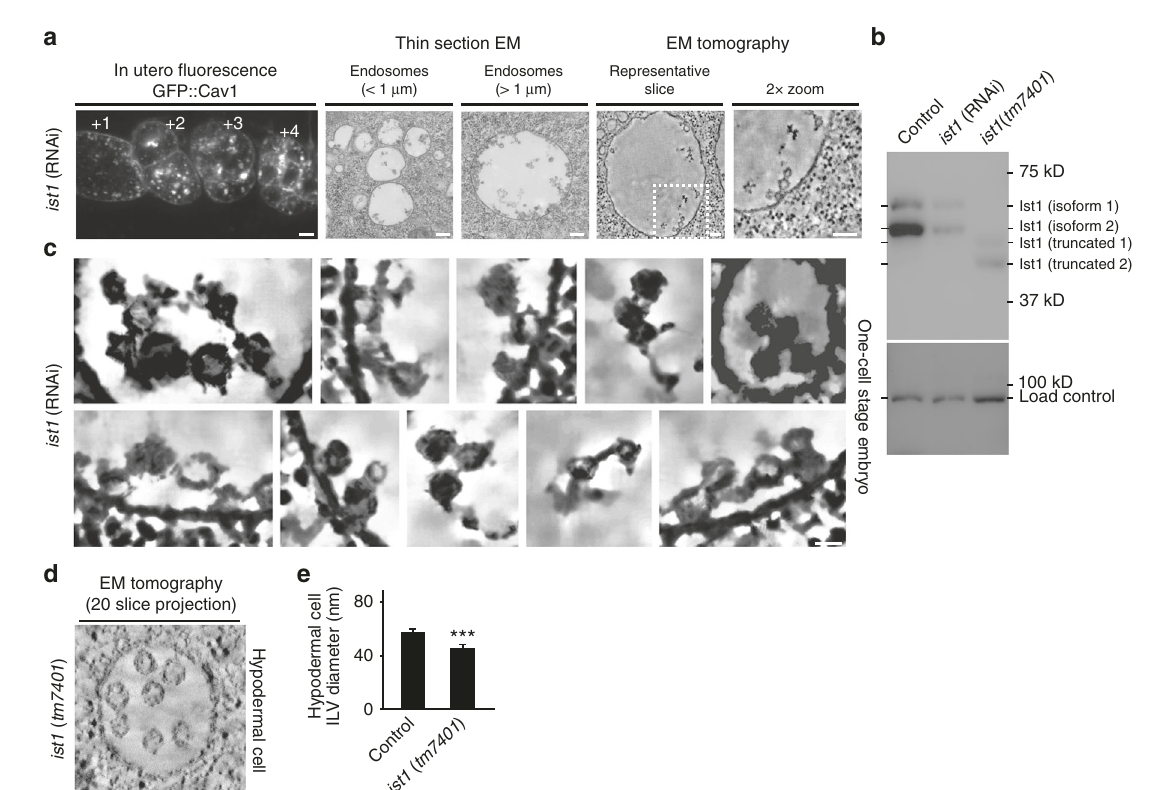
Fig. 4 Ist1 regulates MVE biogenesis. a Animals expressing GFP::Cav1 were depleted of Ist1 using RNAi and imaged using fl uorescence (left panels; n = 20 animals) and electron microscopy. Both thin-section electron microscopy (middle panels; 313 MVEs analyzed) and electron tomography (right panels; n = 13 MVEs analyzed) were conducted to visualize MVE and ILV morphology. Representative images are shown. Bars, 10 μ m (left panels, fl uorescence imaging), 200 nm (middle panels, thin-section EM), and 100 nm (right panels, tomographic slices). b Extracts were generated from control, Ist1-depleted and ist1 ( tm7401 ) mutant animals and separated by SDS – PAGE, followed by immunoblot analysis using antibodies directed against Ist1. Two splice variants have been identi fi ed for Ist1, each of which was detected. c Regions extracted from several tomograms described in panel a were processed for noise reduction and feature enhancement. Bar, 25 nm. d Representative MVE found in a hypodermal cell ( n = 12) from an animal harboring the ist1 ( tm7401 ) mutation imaged using electron tomography. Bar, 50 nm. e Quanti fi cation of ILV diameter found in control and ist1 ( tm7401 ) hypodermal cells. Standard error of the mean is reported in each case. *** p < 0.001, using a t